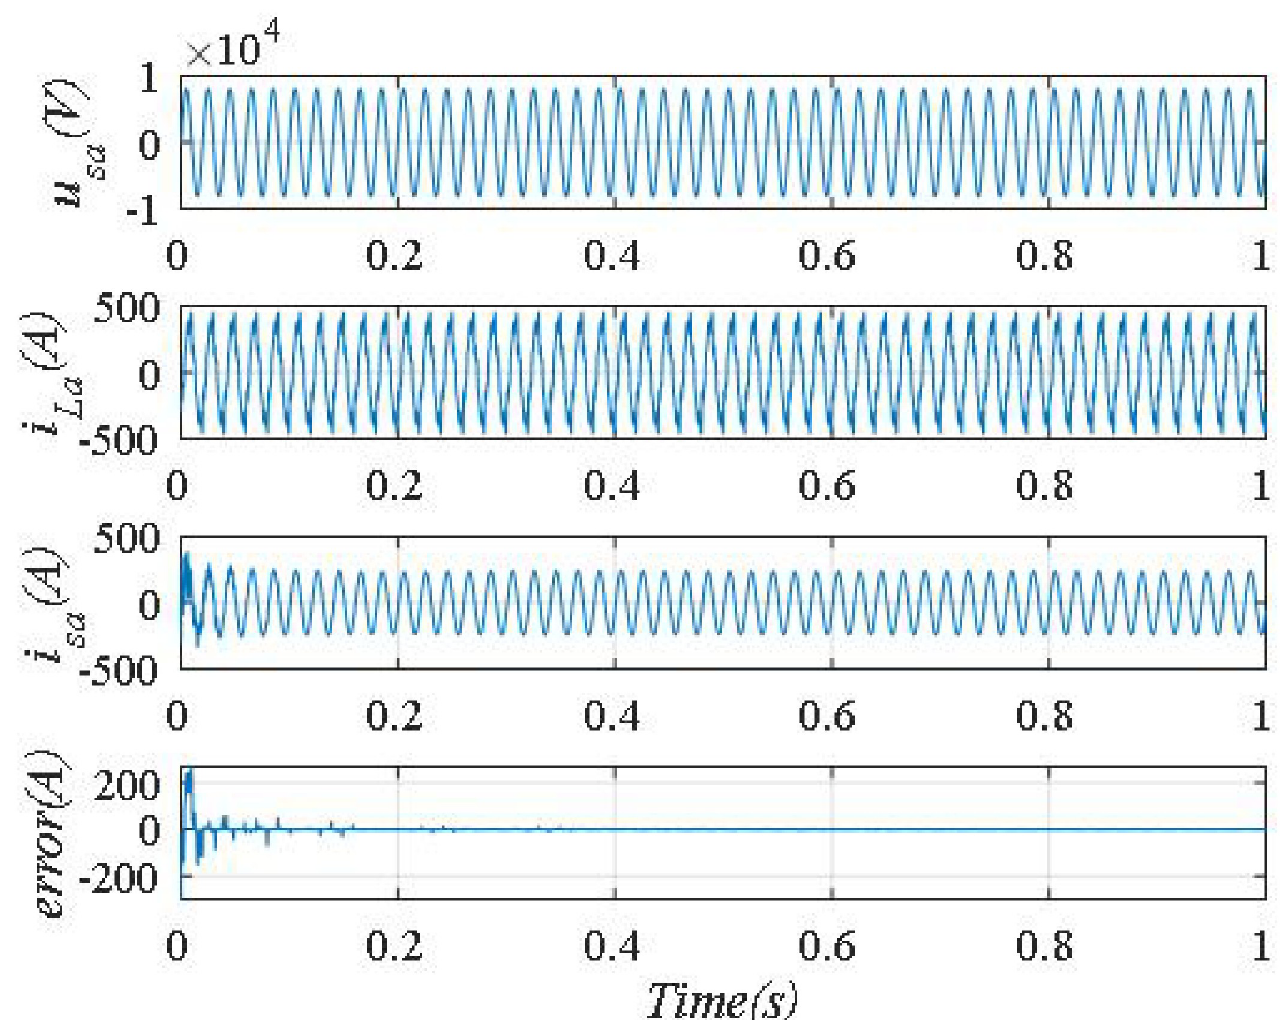
Fig 6. The waveforms corresponding to the best parameter set using the PSO